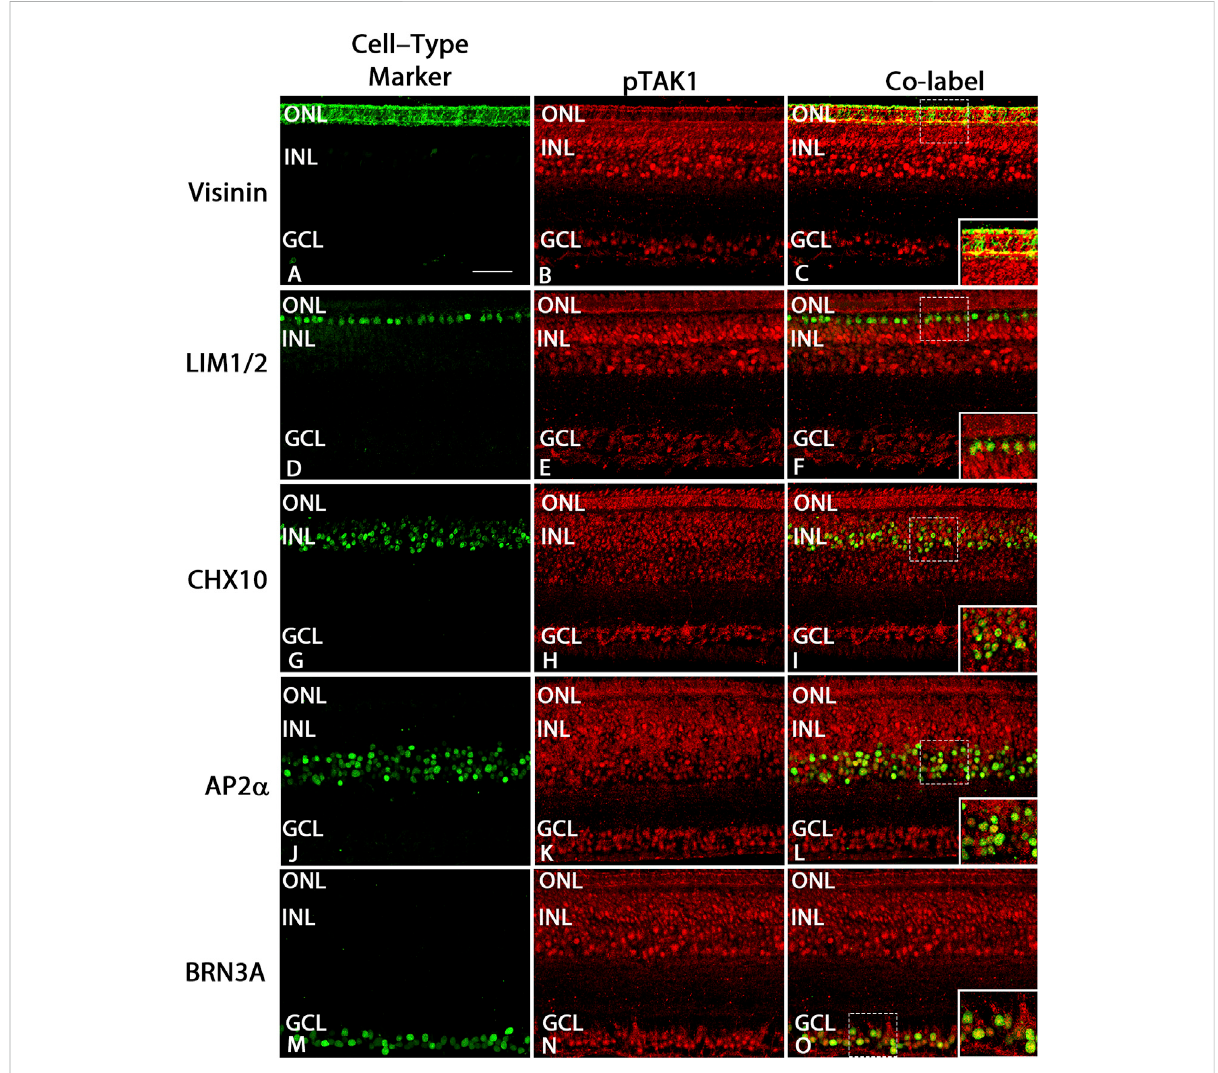
FIGURE 5 pTAK1 was localized to differentiated cells at E18. Chick retinal sections from E18 embryos were double-labeled for pTAK1 and Visinin [photoreceptors; (A – C) ],LIM1/2 [horizontal cells; (D – F) ],CHX10[bipolarcells; (G – I) ],AP2 α [amacrinecells; (J – L) ],orBRN3A[ganglioncells; (M – O) ]. Areas shown by dashed boxes in (C,F,I,L,O) are enlarged and shown in insets in (C,F,I,L,O) . Abbreviations: ONL, outer layer; INL, inner nuclear layer; GCL, ganglion cell layer. Scale bar in A = 50 μ m for images (A – O)